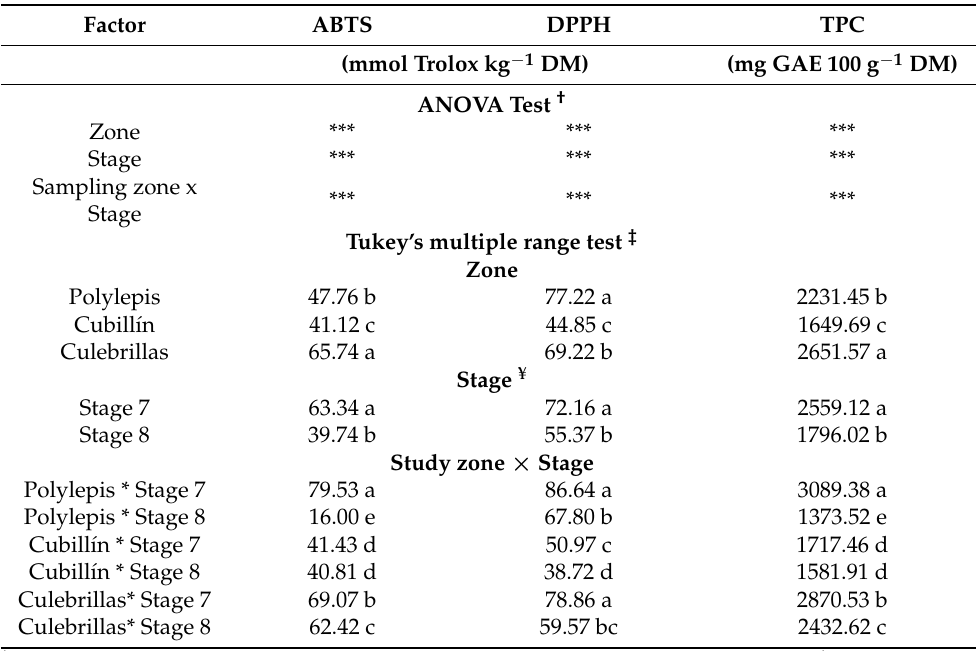
Table 2. Antioxidant activity (mmol Trolox kg − 1 dry matter, DM) and total polyphenol content [mg gallic acid equivalent (GAE) 100 g − 1 DM] in Mortiño berries as affected by sampling area and stage of fruit